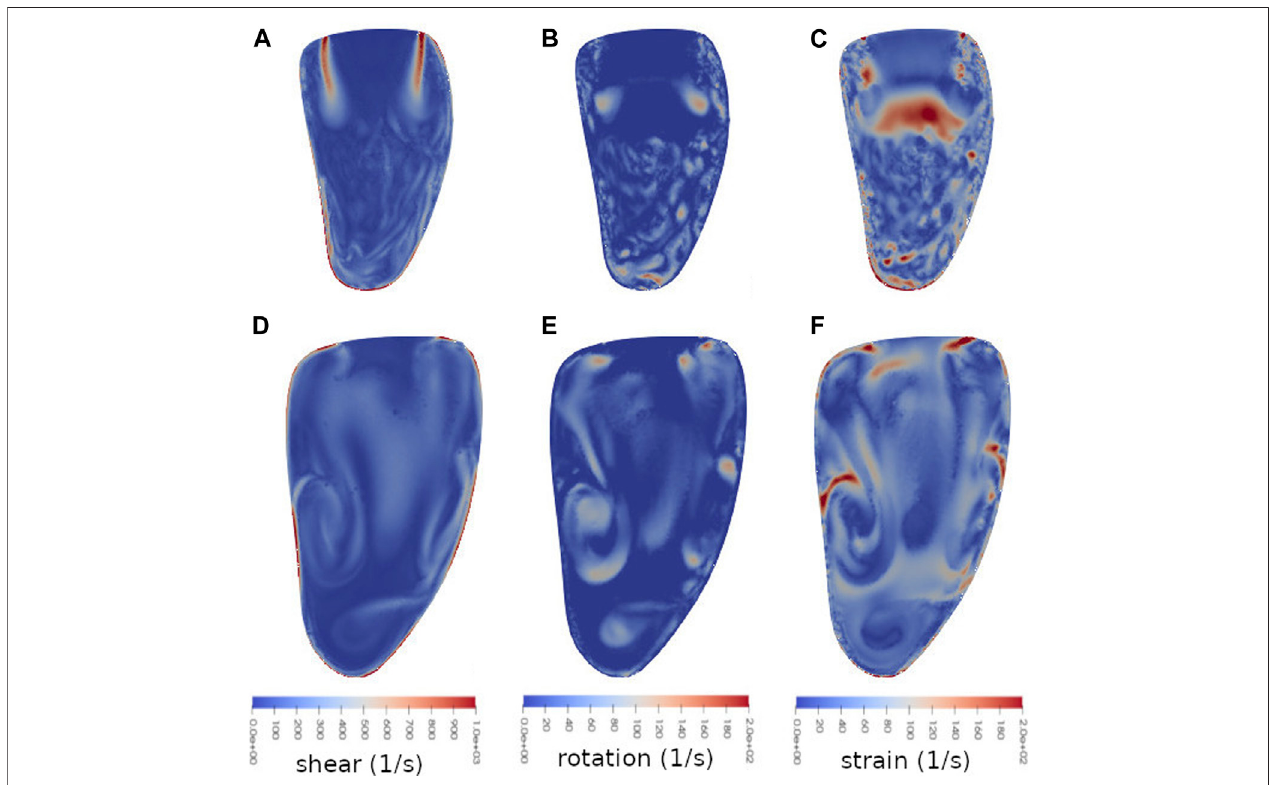
FIGURE 6 | Snapshots of shear fl ow (A and D) , rotational fl ow (B and E) and straining fl ow (C and F) at two times in during diastole: t = 0.45 s (A,B and C) and t = 0.71 s (D,E and F) inaverticalbicommissuralcutthroughtheleftventricle.Thissimulationwasdonewithanuntreated valve.Attime t =0.45 s(earlydiastole),the fl owis dominated by the incoming E-wavejet. The velocity and pressure at this time are shown in Figures 3A , 4A respectively.At time t = 0.71 s (end diastasis) the in fl ow jet is weaker, and the initial dominant fl ow structures of the E-wave have started to break down. Note that the different sizes of the ventricle are due to the diastolic